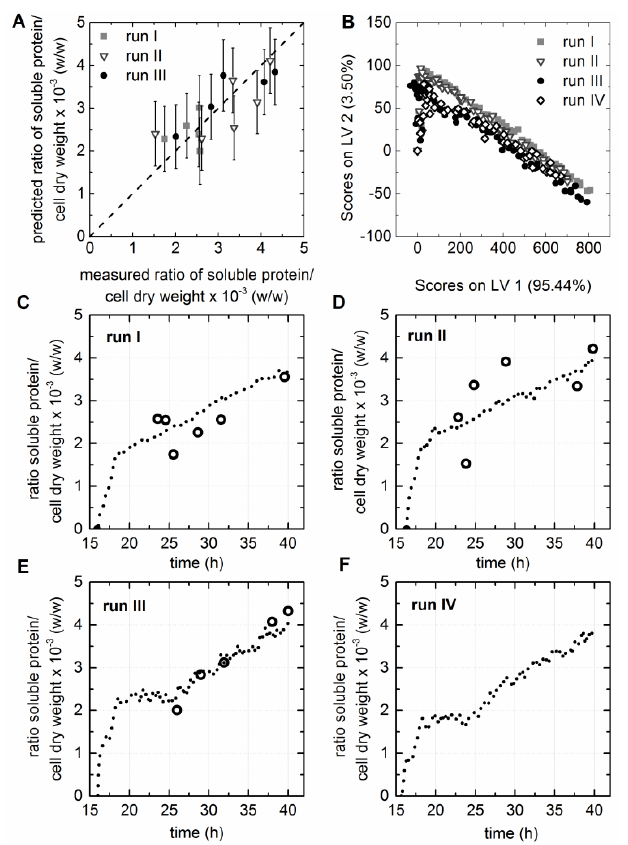
Figure 4 . PLS model for the prediction of soluble protein to cell dry weight ratios. ( A ) The predicted versus reference plot of the PLS model with three LVs. ( B ) The scores values of all EEMs calculated for LV1 and LV2 are shown in the scores plot. ( C–F ) Offline (circles) and predicted values (dashed line) based on the selected PLS model are shown for cultivations I–IV.